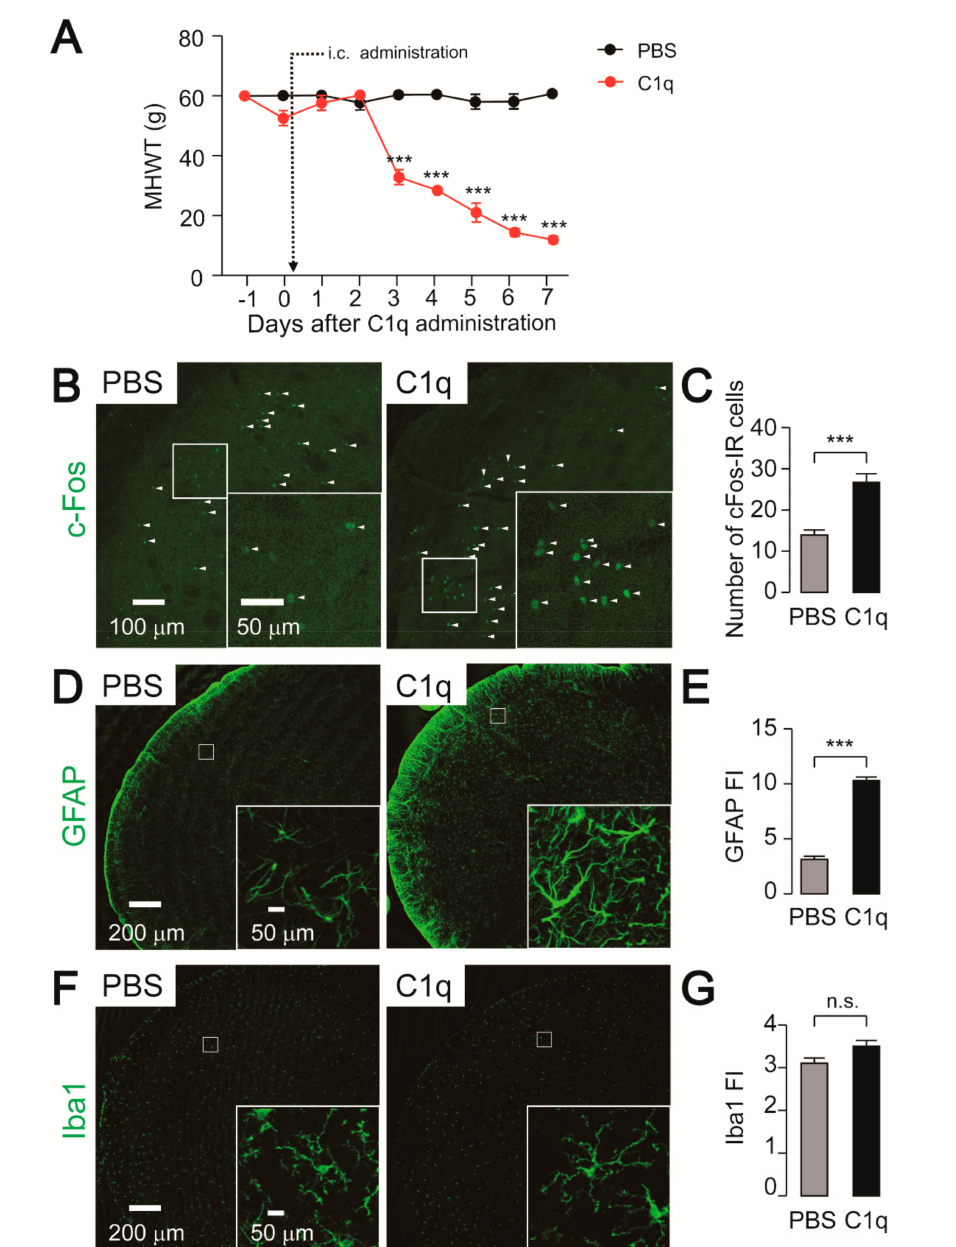
Figure 6. Intracisternal injection of C1q causes mechanical hypersensitivity and astrocytic activation. ( A ) Time-course of mechanical head withdrawal threshold (MHWT) in the whisker pad skin. PBS: n = 5, C1q: n = 5, two-way ANOVA post hoc Bonferroni test, *** p < 0.001 (vs. PBS-treated group). ( B , D , F ) Representative images of c-Fos ( B ), GFAP ( D ), and Iba1 ( F ) immunofluorescence in the Vc 7 days after PBS or C1q administration. Arrowheads indicate c-Fos-IR cells. Insets indicate enlarged images of the region indicated in the open square. ( C , E , G ) Averaged number of c-Fos-IR cells ( C ) and fluorescence intensity (FI) of GFAP ( E ) and Iba1 ( G ) in the Vc on day 7 of PBS or C1q-administrated rats. PBS: n = 5, C1q: n = 5, unpaired Student’s t -test, *** p < 0.001. n.s.: not significant. The data represent the means ±